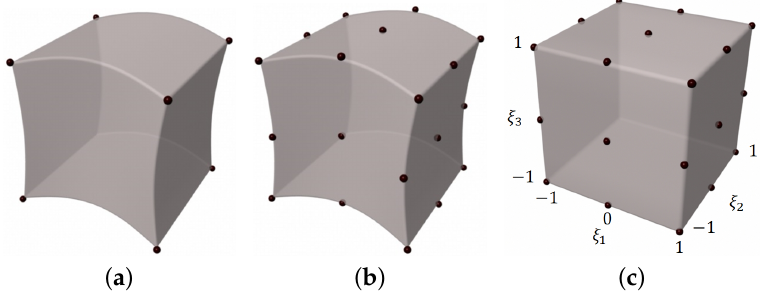
Figure 2. Location of index points in a hexahedron element. ( a ) Nodal points, ( b ) interpolation points, and ( c ) Gauss–Legendre–Lobatto